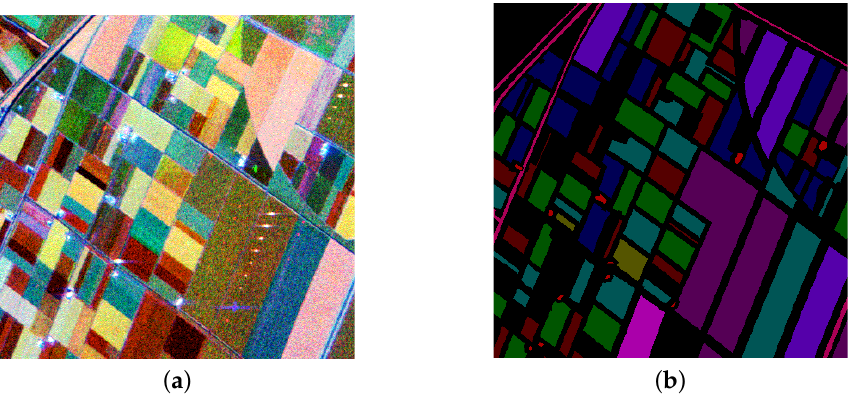
Figure 5. The Flevoland-1991 dataset. ( a ) The pseudo RGB image. ( b ) Ground truth